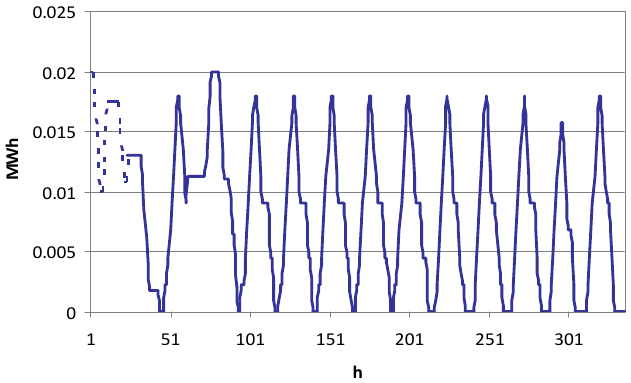
Figure 11. ESS SOC course along 14 days—stable